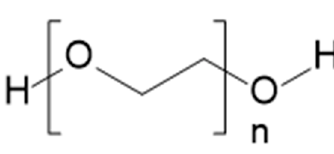
Figure 18. Chemical structure of PEG